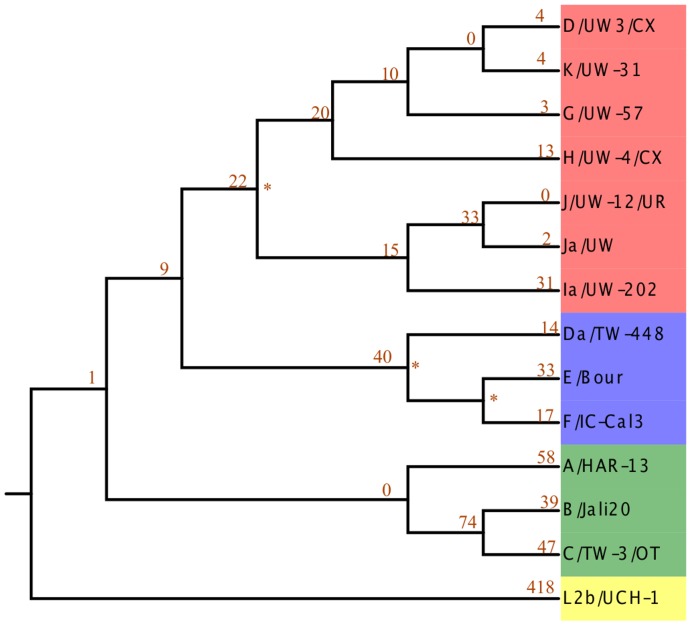
Phylogeny of 100Tree calculated in the same manner as Figure 2 but instead based on the 100 kb region of the C. trachomatis genome selected for targeted amplification. The colors are the same as Figure 3.